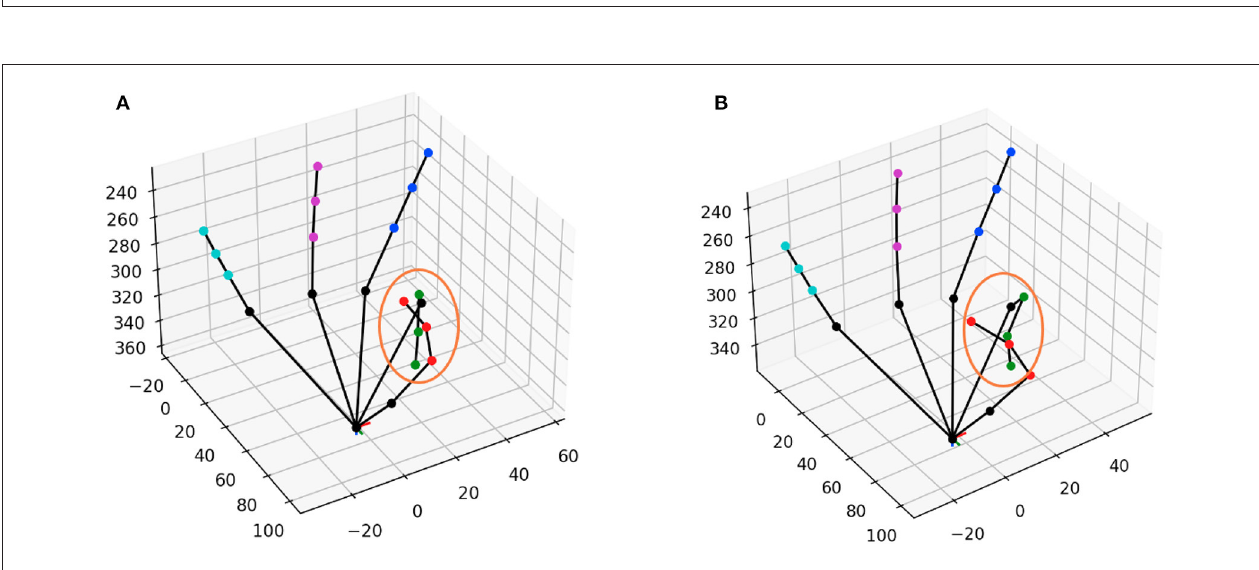
FIGURE 7 | Qualitative comparison between the pose from the MSRA dataset using (A) SSC-CNN and (B) the same pose from Wang et al. (2018). The circle shows the part which is anatomically wrong in (B) while its correctly shown in (A) .